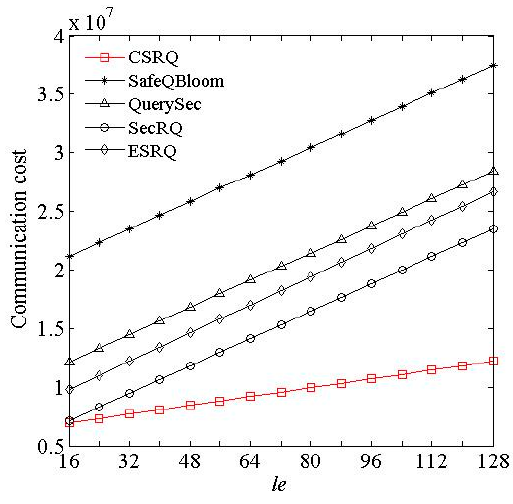
Figure 6. Impact of l e on communication cost.